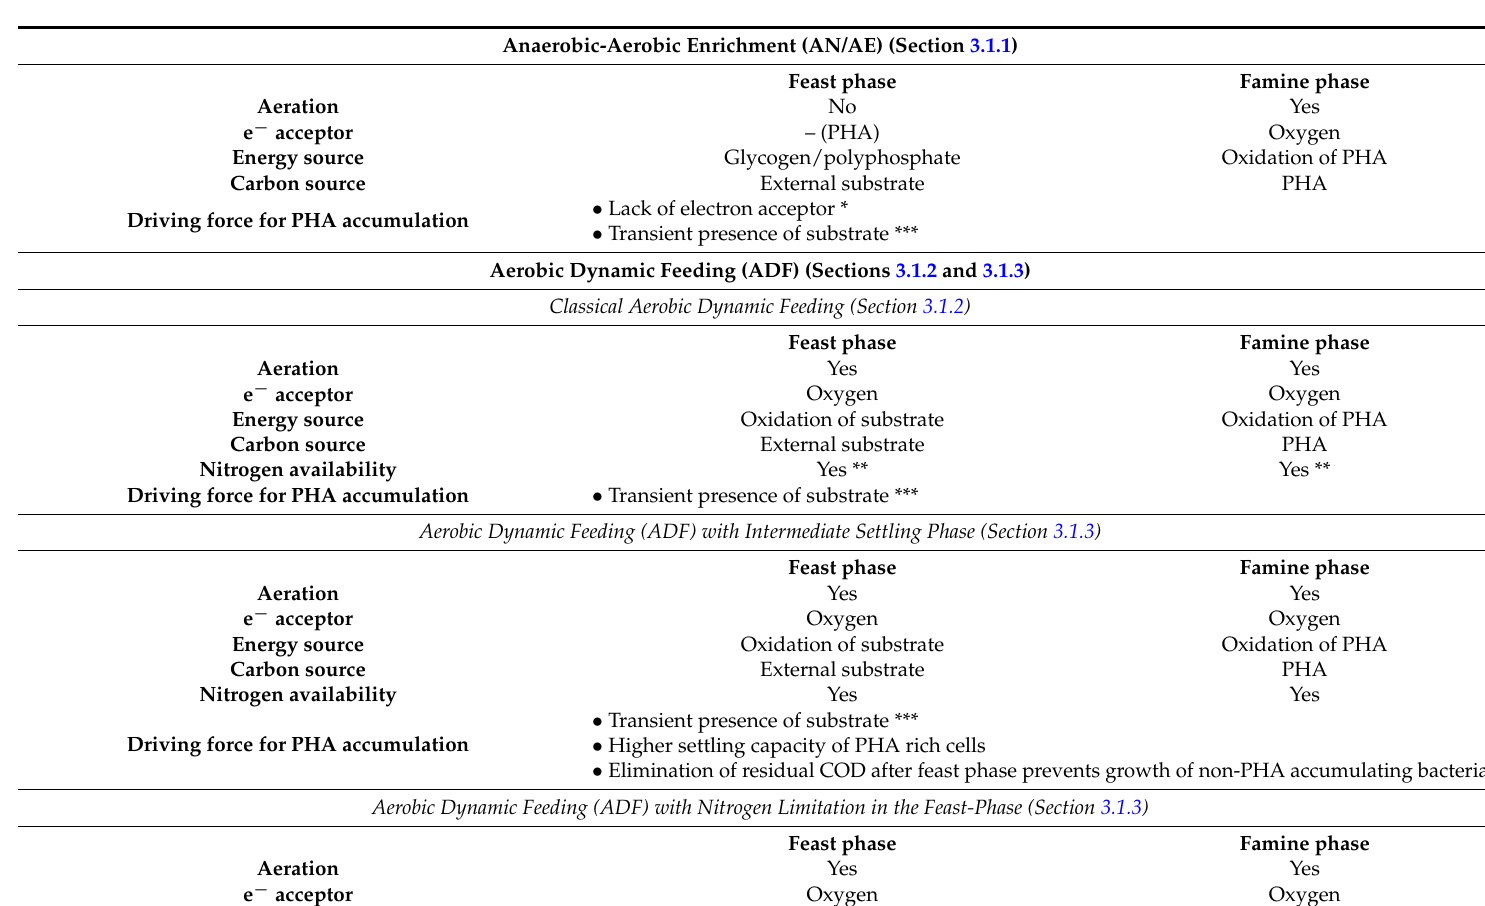
Table 3. Summary on the main characteristics of the enrichment techniques applied for